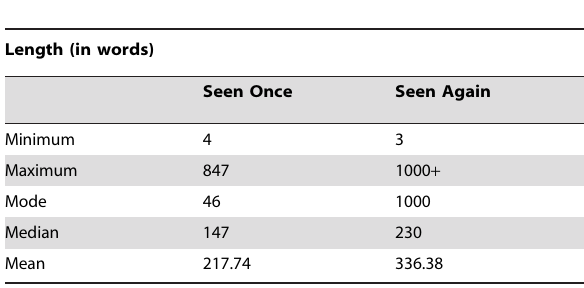
Table 1. Length of original species description in words for oncers and species that have been observed in multiple